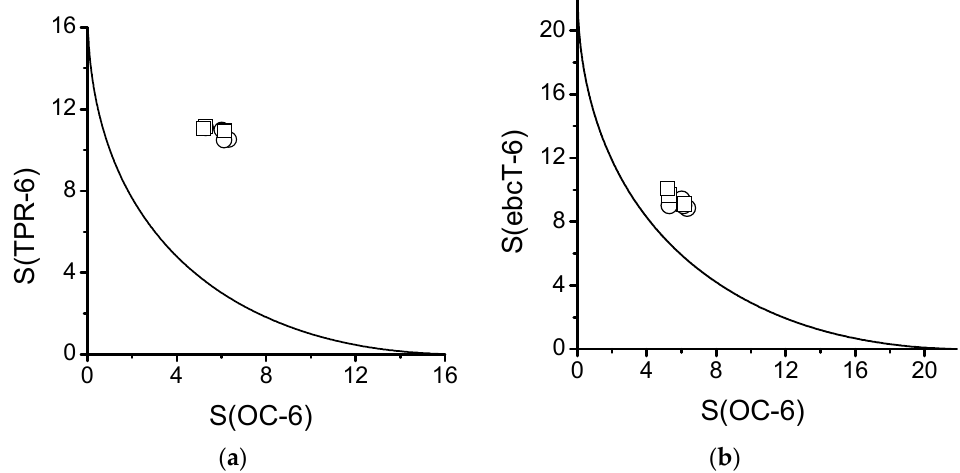
Figure 5. Shape maps for Fe( L1 ) 2 OTf 2 , Zn( L1 ) 2 (ClO 4 ) 2 , Fe( L2 ) 2 OTf 2 and Fe( L2 ) 2 (BF 4 ) 2 that show octahedral S(OC-6) symmetry measure plotted against trigonal prismatic S(TRP-6) ( a ) and edge-bicapped tetrahedral S(ebcT-6) ( b ) symmetry measures. Continuous lines represent minimum distortion pathway between the reference polyhedra, open circles and squares correspond to the coordination geometry according to X-ray diffraction (Table 1) and NMR-based approach, respectively. If referenced to OC-6 and ebcT-6 (Figure 5b), the four complexes feature a rather small